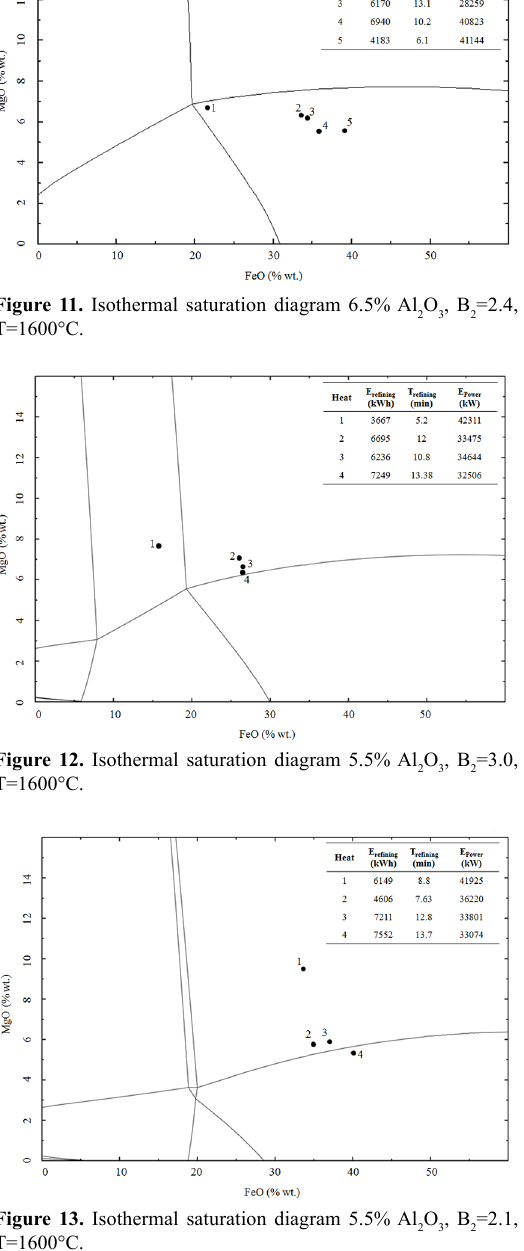
Figure 13. Isothermal saturation diagram 5.5% Al T=1600°C. also refining time. The heats that are closer to the saturation line, showed similar electrical power (around 33000 kW) and the farther ones from the saturation line showed power times resulted in higher energy